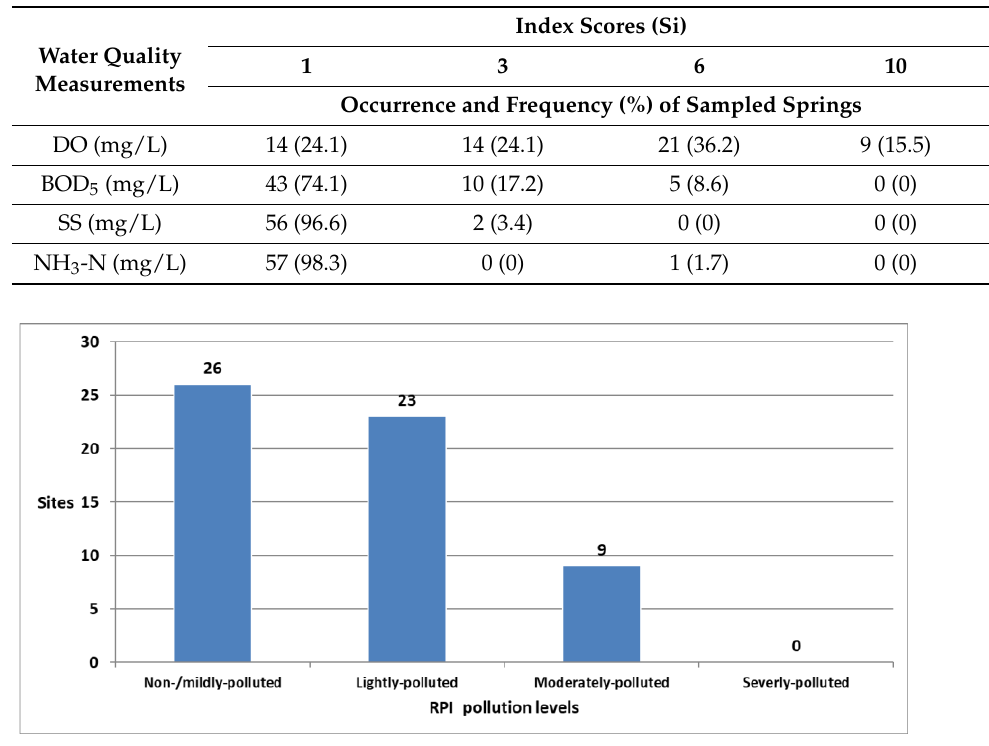
Figure 2. Number of springs grouped into four pollution levels based on the River Pollution Index.